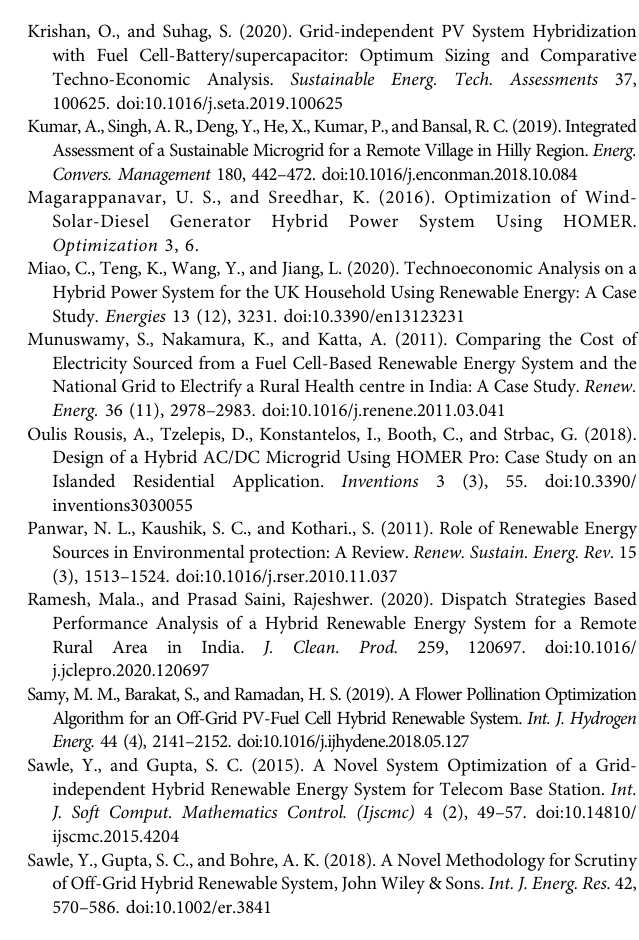
Supplementary Figure S1 | Methodology used in HOMER. Supplementary Figure S2 | Geographical map of